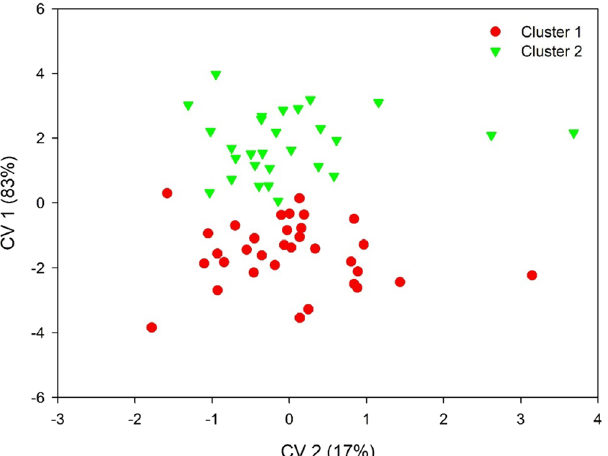
Figure 5. Dispersion of the first two canonical variables (CV1 and CV2) representing the formation of two clusters by the Ward-MLM strategy, based on 14 quantitative and 15 qualitative descriptors in S 1 inbred families of guava trees. UENF, municipality of Campos dos Goytacazes,